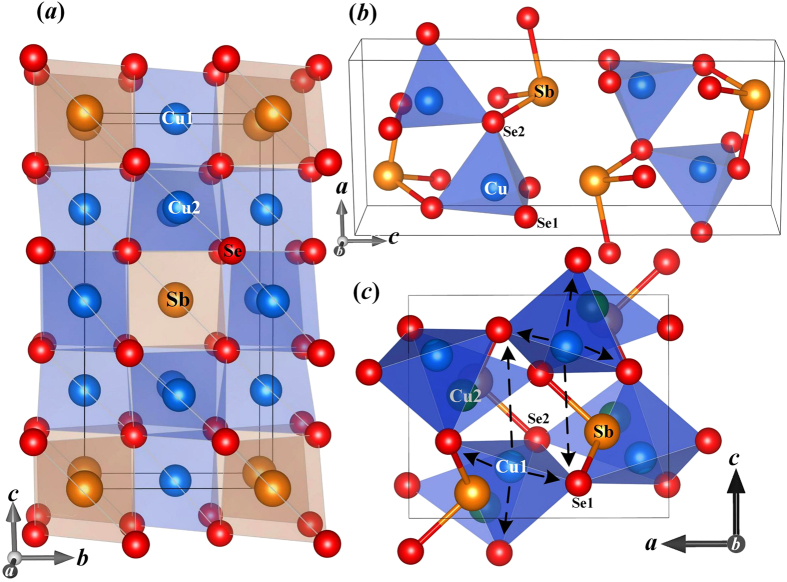
Crystal structures (a) Cu3SbSe4. (b) CuSbSe2. (c) Cu3SbSe3.